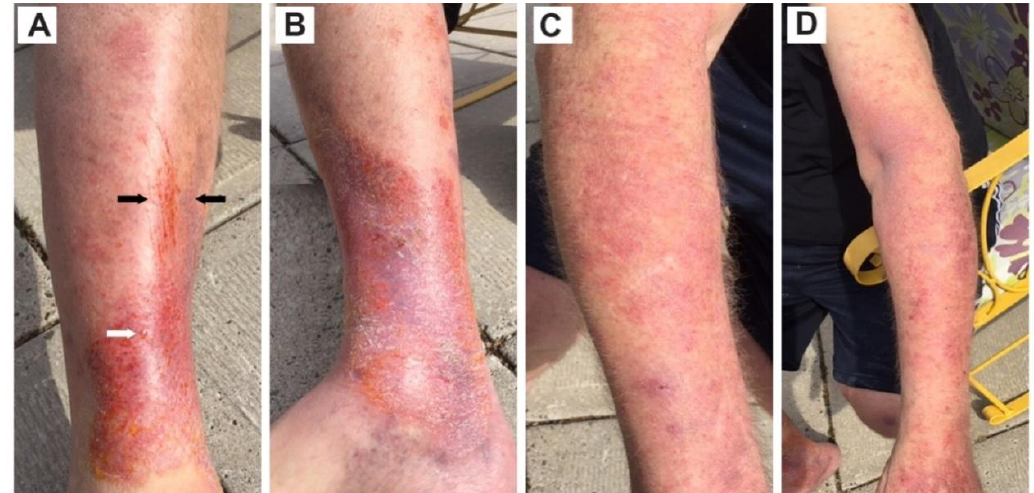
Figure 5. A 64-yr-old male exhibited rashes encompassing a set of co-infections, namely ACA, blister exudate, erythematous rash, and Bartonella streaks (striae). ( A ) Right leg, front view, compound rash with Bartonella striae concomitantly embedded in an inflammatory atrophic ACA at the ankle. The black arrows point to Bartonella striae, and the white arrow indicates exudate droplet typically produced by a blister rash. ( B ) Right leg, inside view, inflammatory atrophic ACA at foot. The orange discoloration is the result of an application of chlorhexidine antiseptic. ( C ) Right arm, diffuse erythematous rash graduating to an inflammatory ACA rash at wrist. ( D ) Left arm, diffuse erythematous rash progressing to inflammatory atrophic ACA at hand.